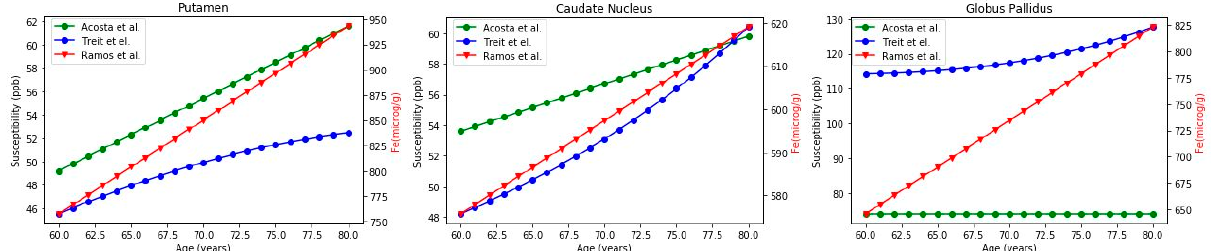
Figure 2. Comparison of the iron concentration estimated with QSM (susceptibility expressed in ppb, reported on the left-side scale, and interpolated by the green and blue curves) and post-mortem analysis (expressed in μ g/g, reported on the right-side scale, and interpolated by the red curve) in three brain areas (putamen, caudate nucleus, and globus pallidus). On the x-axis, the age, in the range of 60–80 years, is reported [16,23,26].